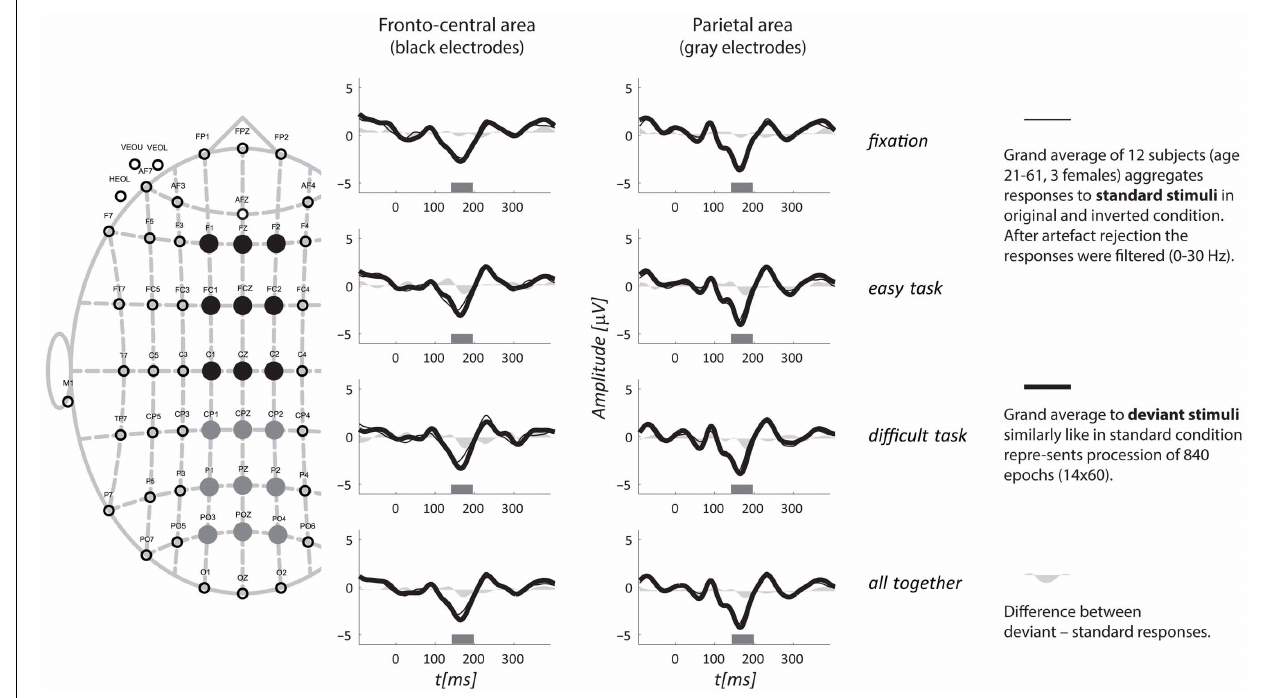
three rows display responses from the three tasks separately, and the fourth row shows all tasks together. The interval of interest, for which the mean amplitude was evaluated, is depicted as a gray rectangle along horizontal